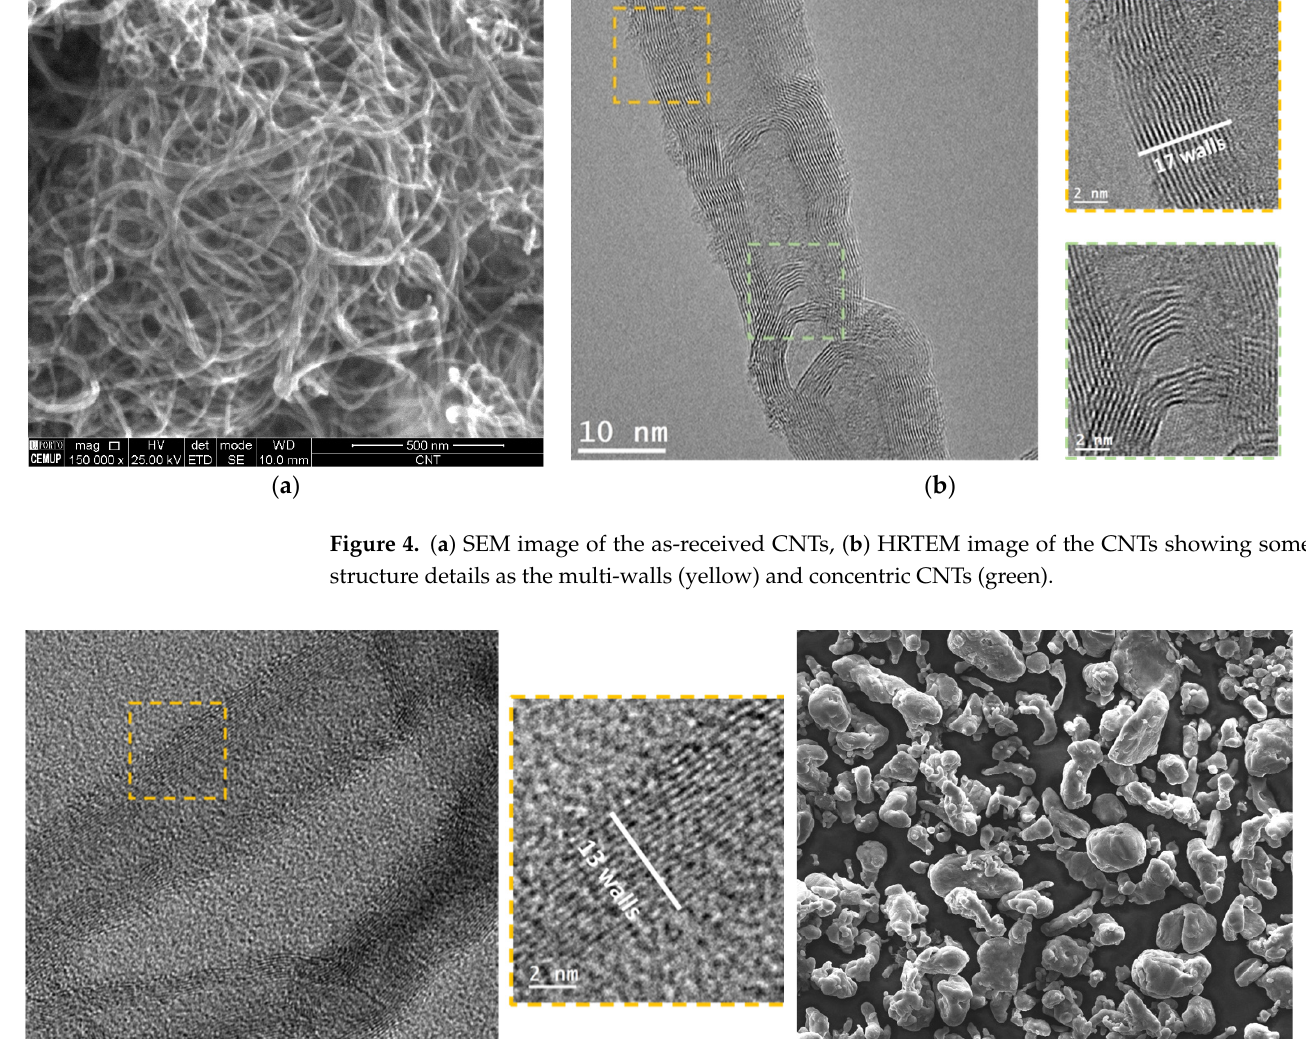
Figure 3. Full analysis of the Al powder as received showing ( a ) Scanning electron microscopy (SEM) image of Al powders, ( b , c ) exemplifying particle analyzed with electron backscatter diffrac- tion (EBSD) with an ( a ) inverse pole figure map and ( b ) Kernel average misorientation map, ( d ) size distribution and ( e ) average values of length and width of the particles.